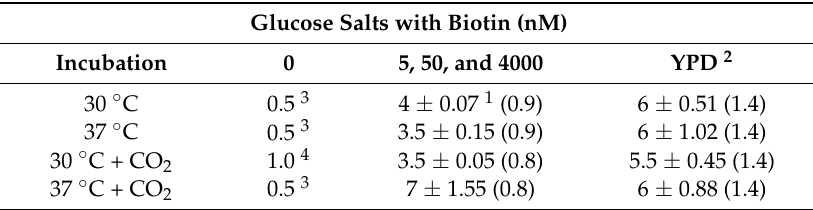
Table 4. Influence of biotin and 5% CO 2 on colony diameter 1 and colony weight after 5 days. Glucose Salts with Biotin (nM)